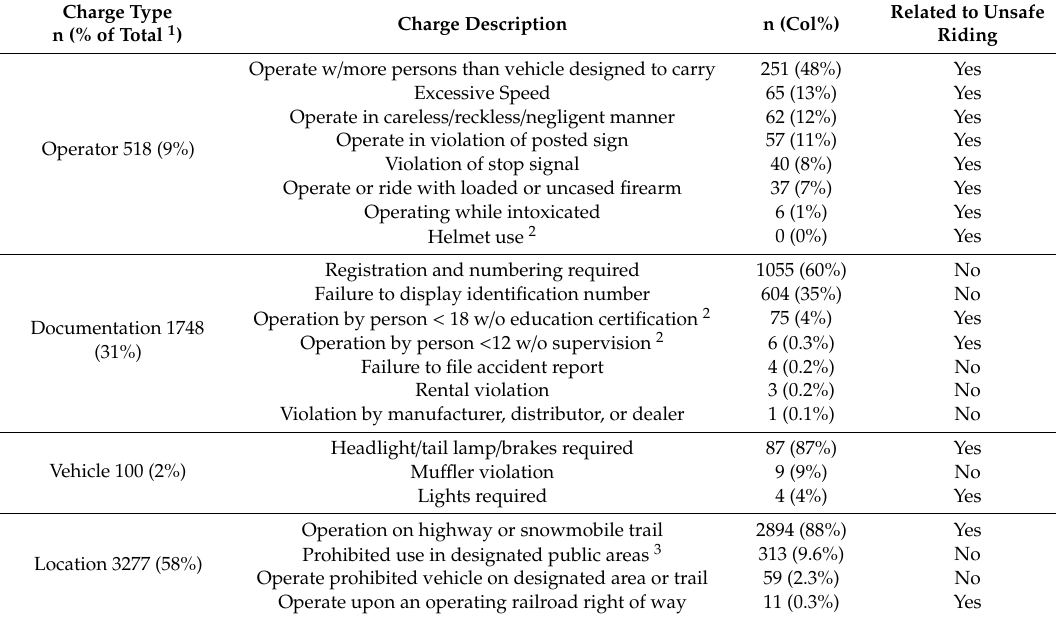
Table 1. List and frequency of o ff -road vehicle (OHV) citations in the Iowa Courts Information System (ICIS) from 2005–2015. All citations fell under Iowa Code 321I.